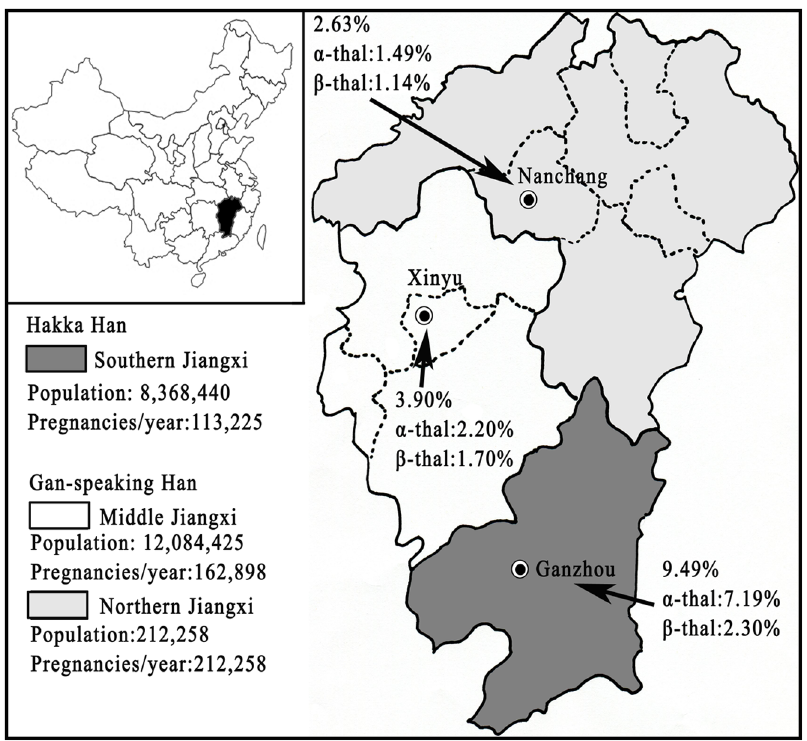
Figure 1. Geographic location of the Jiangxi province and three regional centers of our study. doi:10.1371/journal.pone.0101505.g001 (Table 2). HBB: c.316–197C . T and HBB: c.126_129delCTTT accounted for 64.5% (111/172) of these mutations, again in